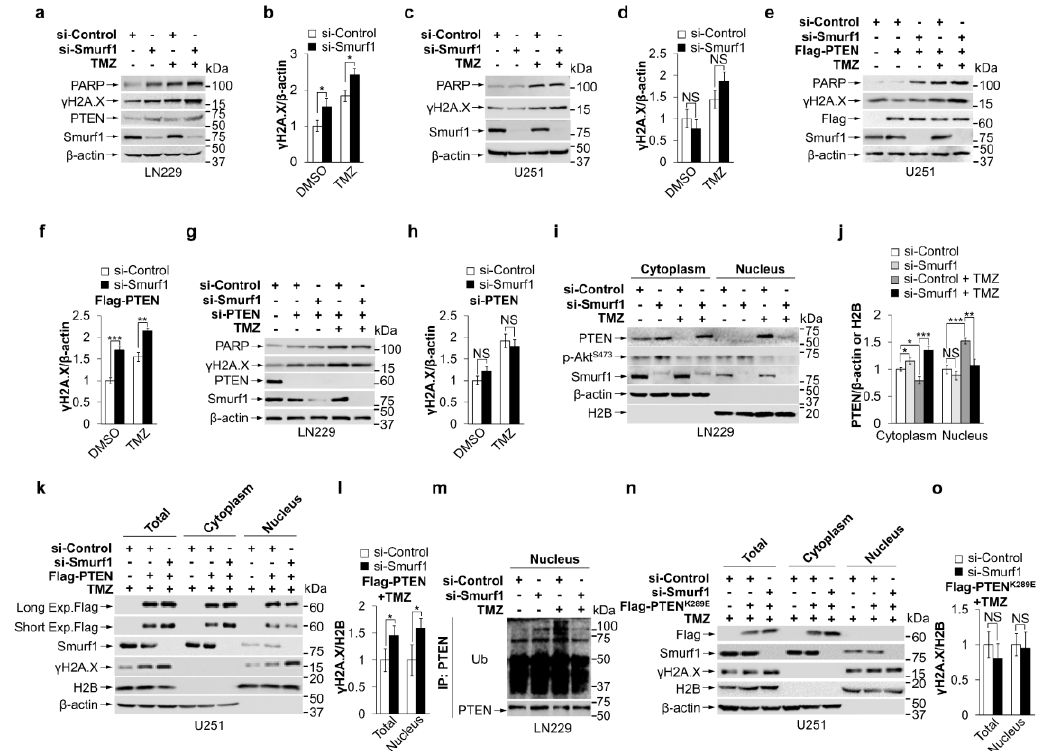
Figure 2. Smurf1 facilitates PTEN nuclear translocation to repair DNA damage under TMZ treatment ( a – h ): LN229 ( a , b ), U251 ( c , d ), U251 with Flag or Flag − PTEN overexpression ( e , f ), and LN229 treated by control or PTEN siRNA oligos ( g , h ) were transfected with si − Control or si − Smurf1 and then treated with DMSO or TMZ (250 μM, 48 h). Whole− cell lysates were examined by Western blotting with anti − PARP, anti −γH2A.X, and anti− PTEN antibodies ( a , c , e , g ). The overexpression or knockdown efficiency was examined with anti − Smurf1 or anti −Flag antibodies. β− actin was used as a loading control. The graph shows the relative γH2A.X intensity ( b , d , f , h ). Values were normalized against the number of cells treated with control siRNA oligos and DMSO. ( i , j ) LN229 cells were transfected with si − Control or si −Smurf1 and then treated with DMSO or TMZ (250 μM, 48 h). Cytosolic and nuclear fractions of cells were separated and subjected to Western blot analysis with anti − PTEN, anti − Smurf1, anti − p − Akt S473 , anti −β− actin, and anti − H2B ( i ). The graph shows the relative PTEN intensity ( j ). Values were normalized against the amount of LN229 treated with control siRNA oligos and DMSO; ( k , l ) U251 with Flag or Flag − PTEN overexpression were transfected with si − Control or si −Smurf1 and then treated with DMSO or TMZ (250 μM, 48 h). Cytosolic and nuclear fractions of cells were separated and subjected to Western blot analysis with anti − Flag, anti − Smurf1, anti −β− actin, anti − H2B, or anti −γH2A.X ( k ). The graph shows the relative γ H2A.X intensity ( l ). Values were normalized against the amount of Flag − PTEN U251 treated with control siRNA oligos and TMZ. ( m ) LN229 cells were transfected with si − Control or si − Smurf1 and then treated with DMSO